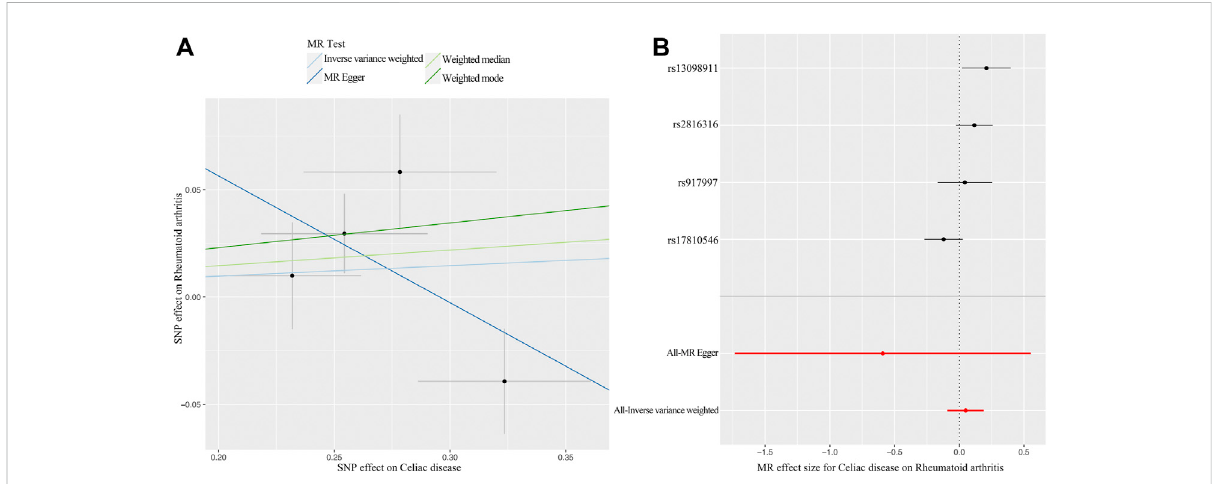
FIGURE 4 MR plots for the causal effect of CD on RA. (A) Scatter plot for the causal relationship of CD on RA. (B) Forest plot for the causal relationship of CD on RA. Abbreviation: MR, Mendelian randomization; CD, celiac disease; RA, rheumatoid arthritis; SNP, single nucleotide